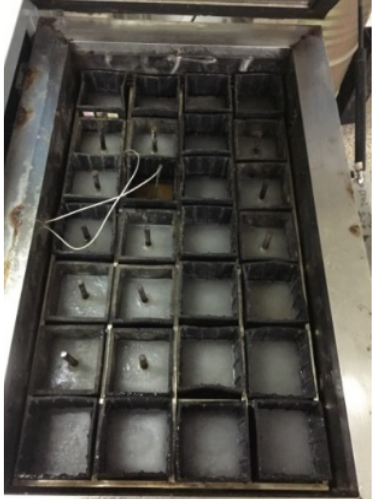
Figure 2. Freeze–thaw test for specimens.